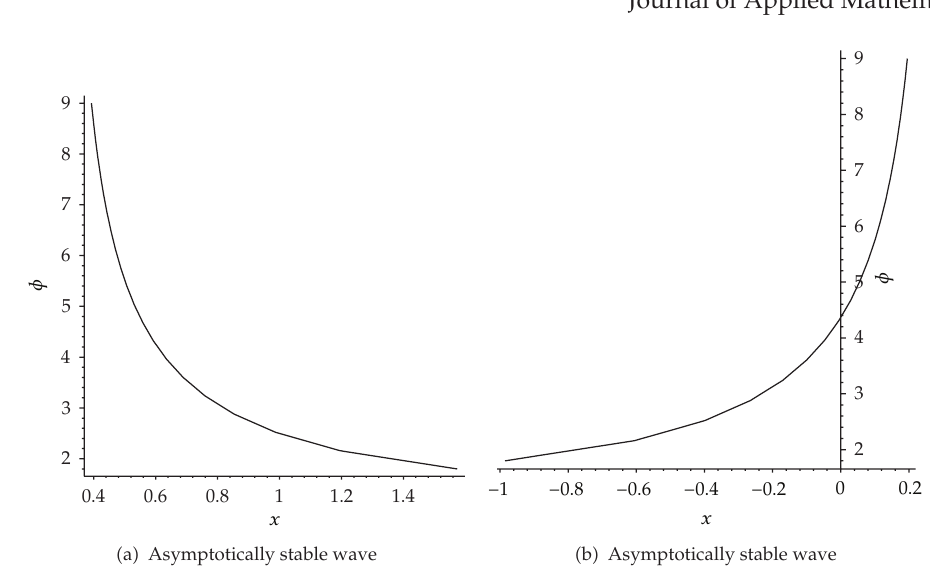
Figure 5: Waveforms of two asymptotically stable solutions in (cid:2) 3.40 (cid:3) when n (cid:8) 4 , σ (cid:8) − 1 , and t (cid:8)